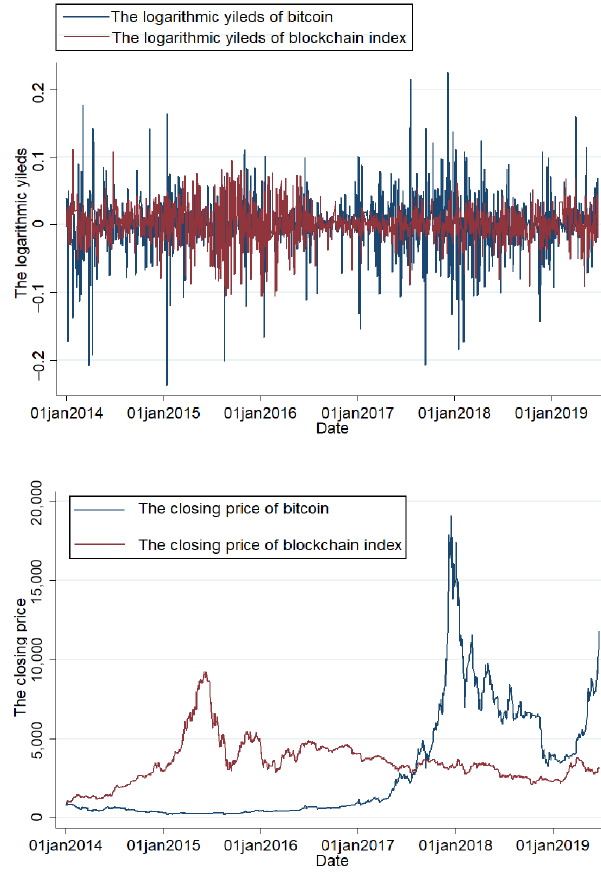
Figure 6. Trend diagram of bitcoin and the blockchain index closing